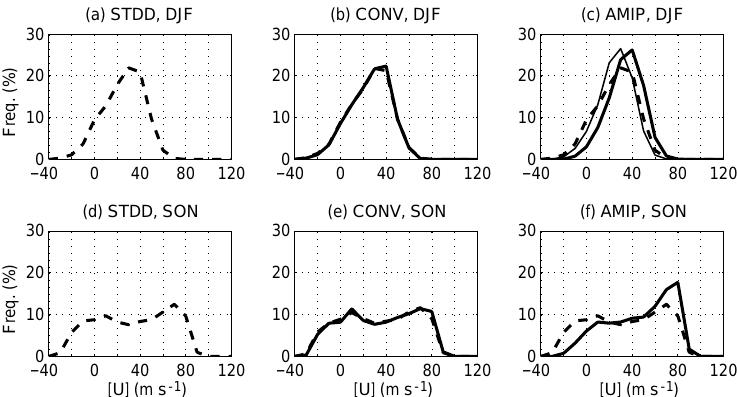
Figure 4. PDFs of the daily zonal mean zonal wind at 60 ◦ N, 10hPa, for DJF (a–c) and at 60 ◦ S, 10hPa, for SON (d–f) in broken lines (a, d) or in solid lines (the other panels). Panels (a, d) are for STDD, (b, e) for CONV, and (e, f) for AMIP. Broken lines in (b, c, e, f) denote the results from STDD. The STDD data after the 1972–1973 season are used in (b, e) . In panel (c) , an additional PDF is drawn in the thin solid line for the AMIP zonal wind data that are artificially decreased by the climatological difference from STDD, so that the decreased wind data have the same mean value as in STDD.